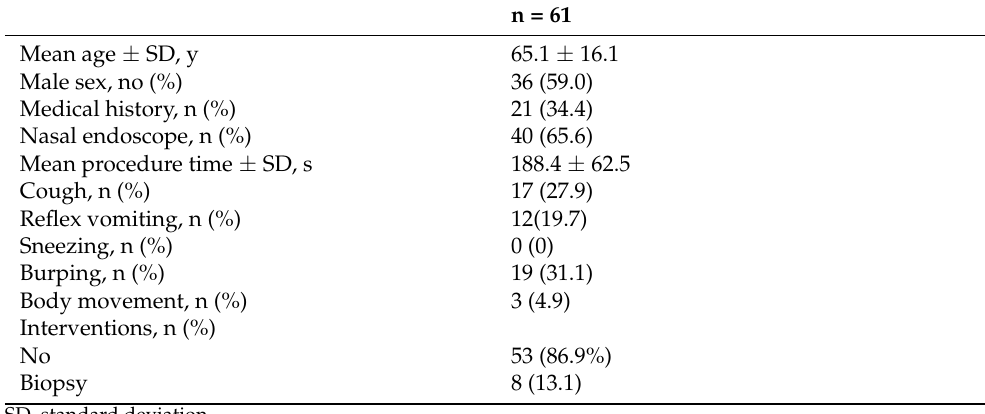
Table 1. Patient characteristics.